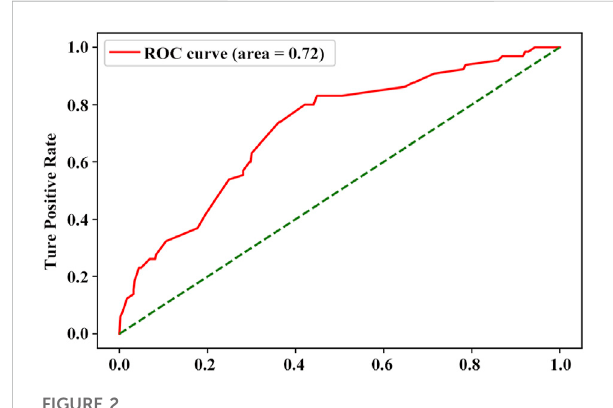
FIGURE 2 ROC curve for MIH in participants. ROC, receiver operating characteristic curve.